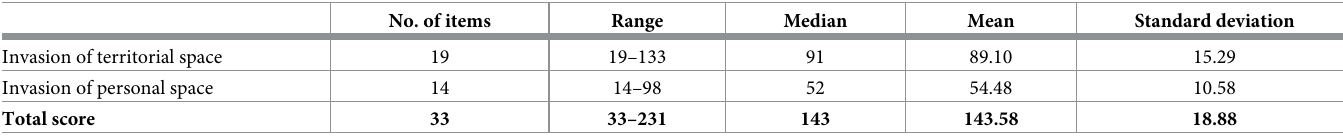
Table 2. Total score and subscale scores of the Anxiety Due to Territory and Space Intrusion Questionnaire. No. of